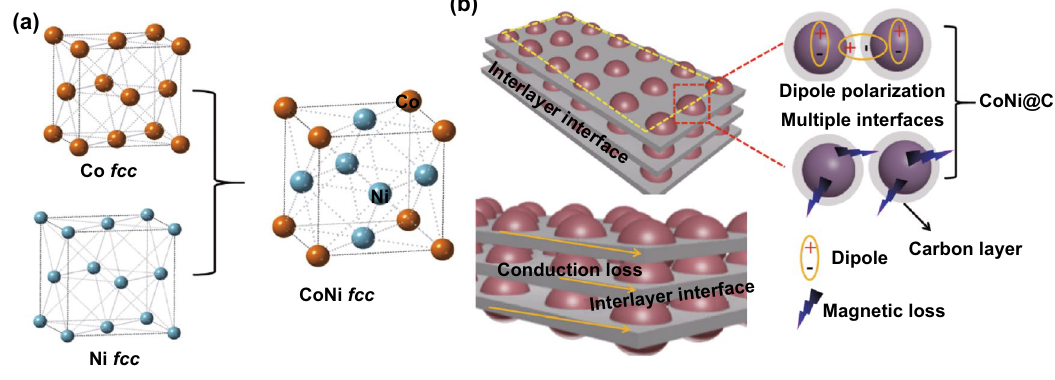
Fig. 6 a Atomic structure diagrams of Co, Ni, and CoNi. b Possible microwave absorption mechanism of Co x Ni y